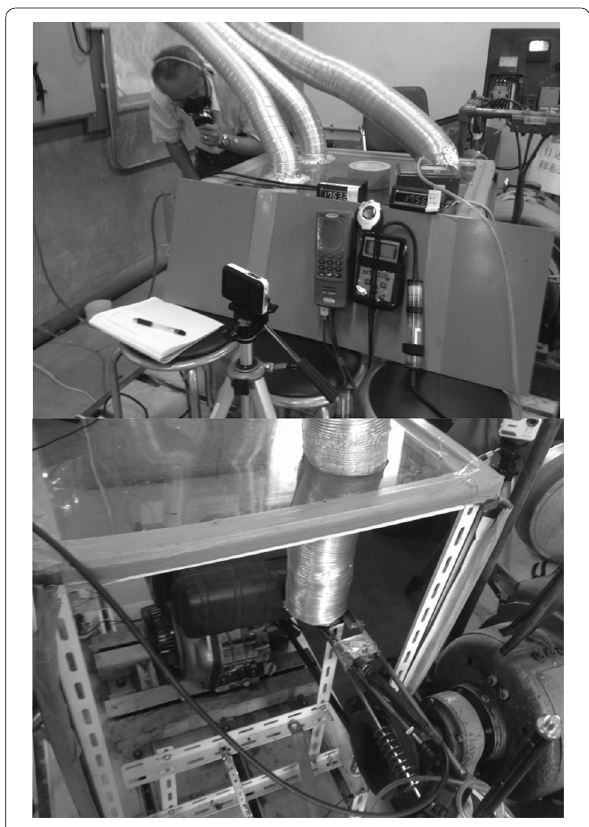
Fig. 1 Diesel engine, dynamometer and exhaust measurement